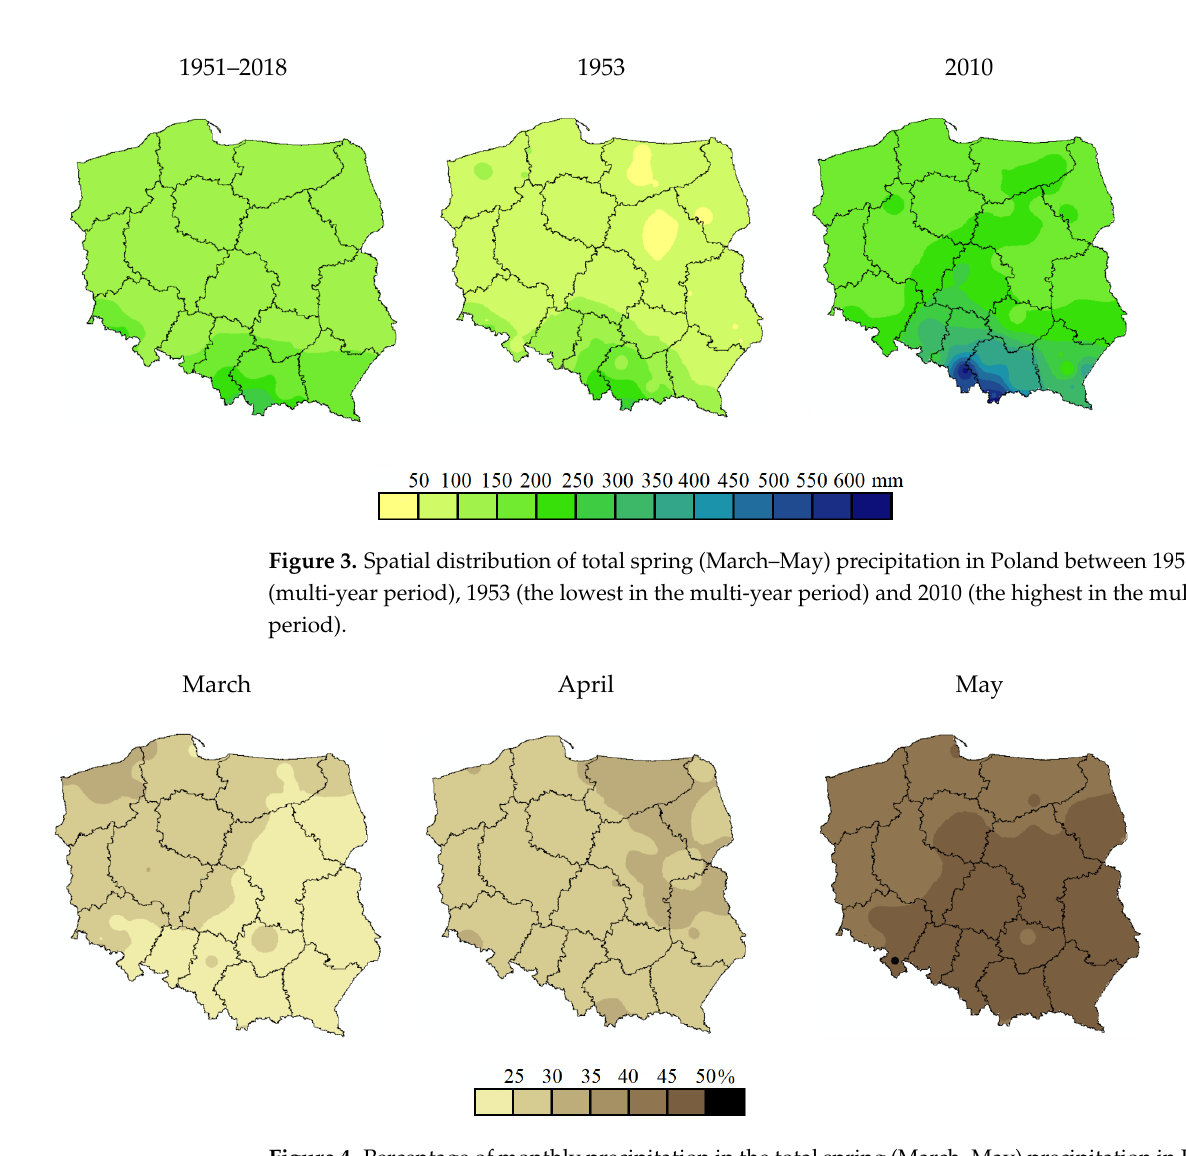
Figure 4. Percentage of monthly precipitation in the total spring (March–May) precipitation in Poland. Years 1951–2018.